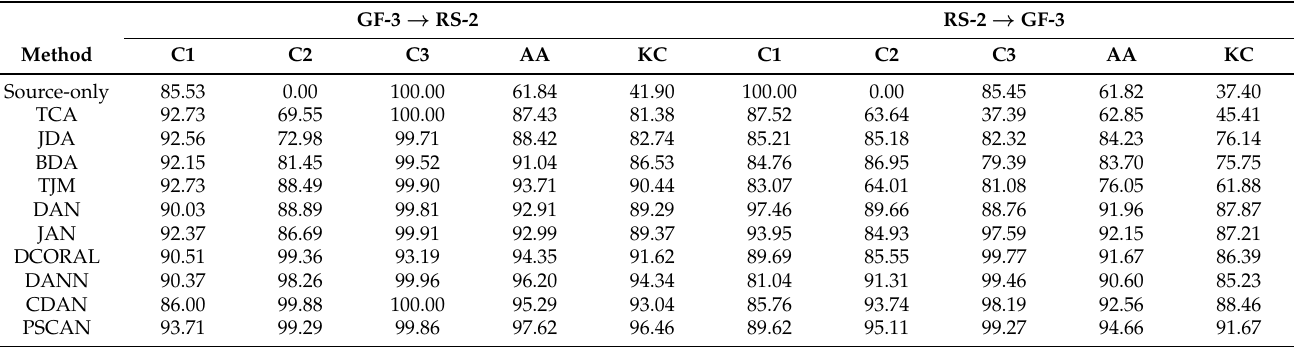
Table 5. Comparison of experimental results (%) on the Qingdao area. The C1 to C3 refer to different respective categories: Urban, Vegetation, and